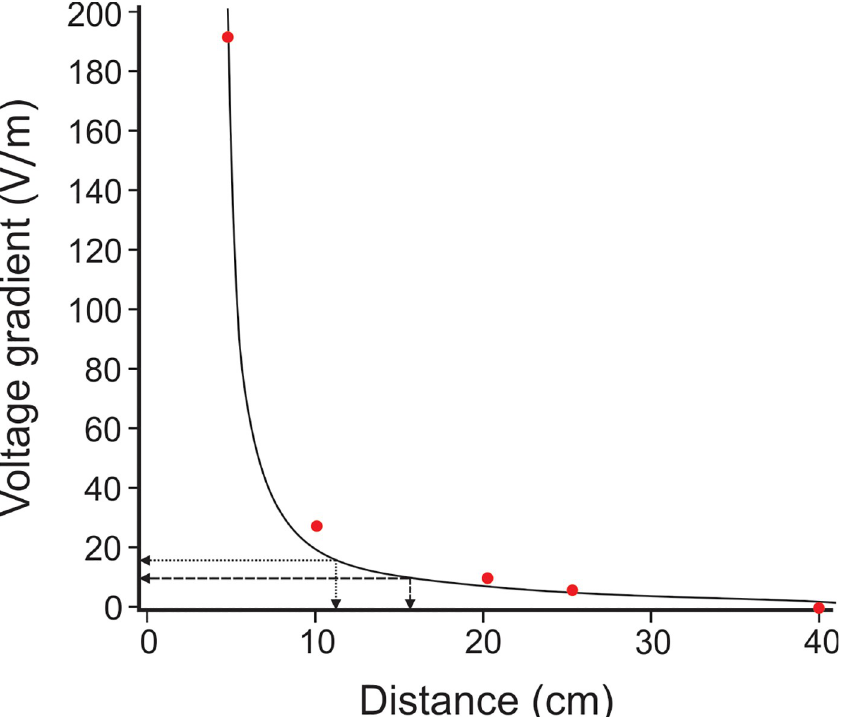
Fig 6. Plot to show the voltage gradient decline of the ESDS with increasing distance. The short-dashed arrows indicate the average deterrent threshold of C . carcharias (15.7 V/m [22]) and the corresponding estimated effective deterrent range of the ESDS (11.6 cm). The long-dashed arrows indicate the average deterrent threshold of C . carcharias during their first encounter with an electric field (9.7 V/m [22]) and the corresponding estimated effective deterrent range of the ESDS (16.9 cm). Red dots depict actual voltage gradient measurements recorded for the ESDS. Voltage gradient curve plotted using Harris model: y = 1/(-0.06s82+0.0239x^0.6961).